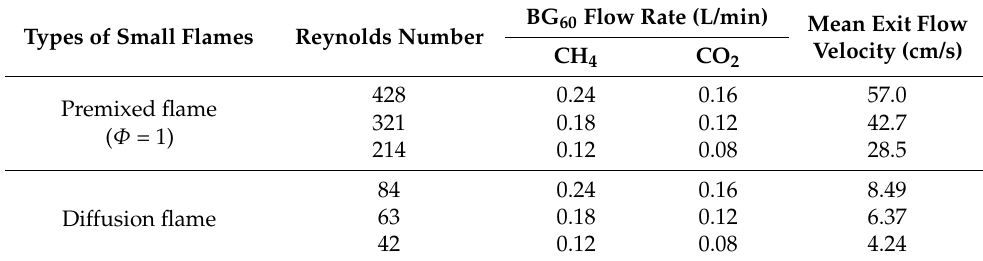
Figure 1. Sketch of experimental setup (flames with and without magnetic fields are illustrated by dashed and solid lines, respectively). Table 1. Experimental flow conditions